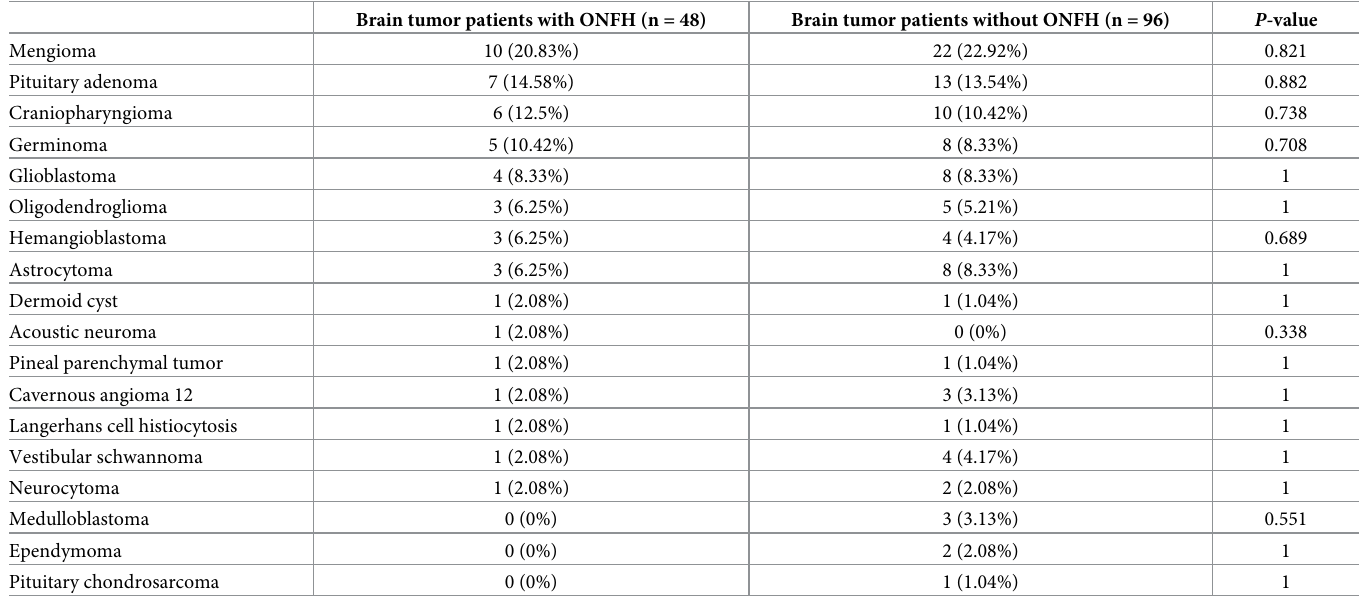
Table 1. Comparison of brain tumors between the 48 brain tumor patients with ONFH (case) and 96 matched brain tumor patients without ONFH (control). Brain tumor patients with ONFH (n = 48) Brain tumor patients without ONFH (n = 96) P